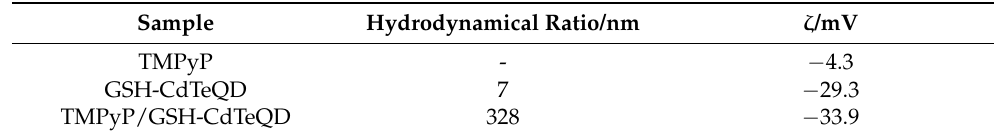
Table 1. Values of Zeta Potential and hydrodynamical ratio obtained by DLS obtained for TMPyP and GSH-CdTeQD separately and